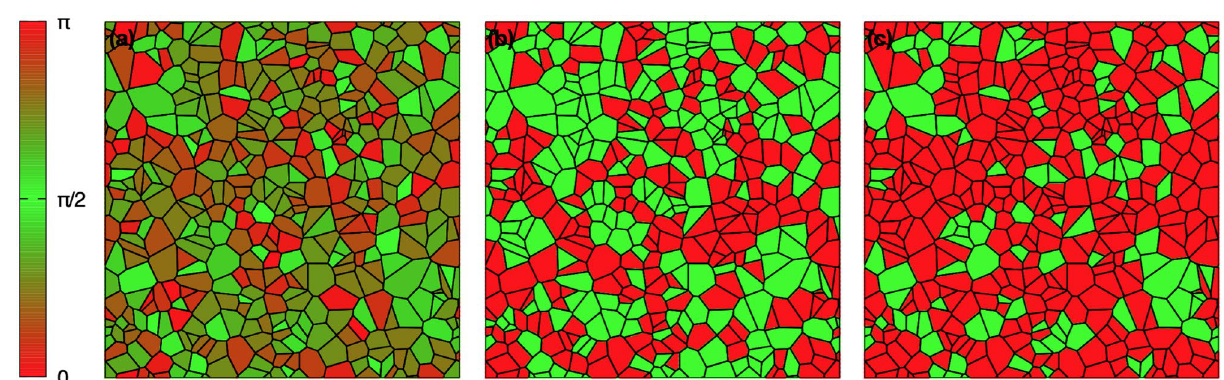
Figure 5. Resulting equilibrium variant distribution with random grain orientation. ( a ) Grain orientation map corresponding to the microstructures. In the color bar the grain rotation angle is given in radian (modulo π due to symmetry). The rotation axis is along the [001] direction. The microstructures consist of 400 grains and tensile strain is applied in horizontal ( x ) direction. The grains have a random orientation, which is the same for all cases, based on a uniform distribution. The tensile strain in horizontal direction is ( b ) 2.1 . Red (green) grains correspond to variant s ε xx /ε 0 � � =